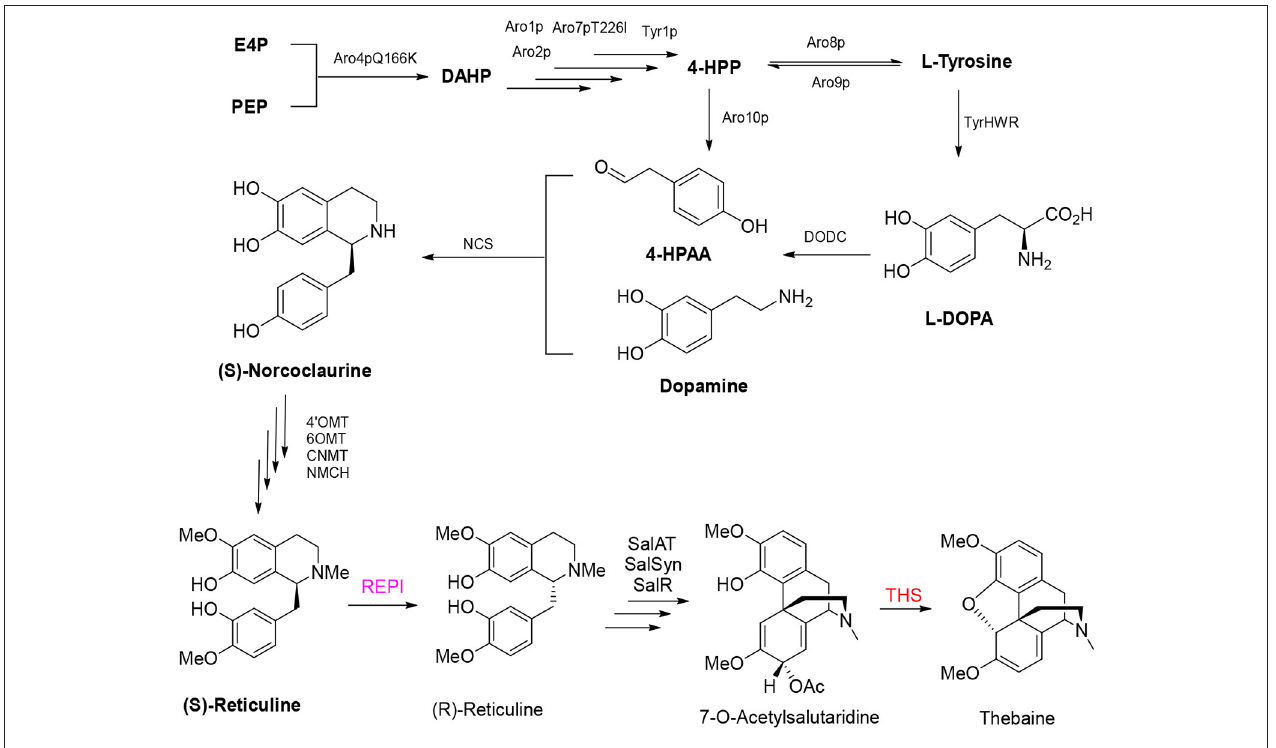
FIGURE 5 | Production of thebaine in engineered